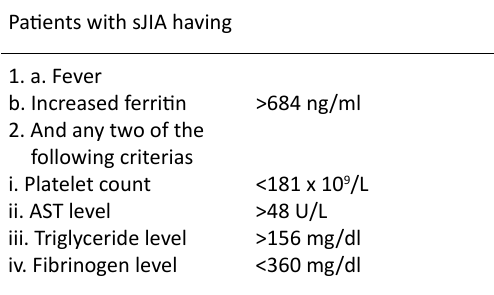
Table 5. EULAR/ACR criteria for MAS in sJIA Patients with sJIA having